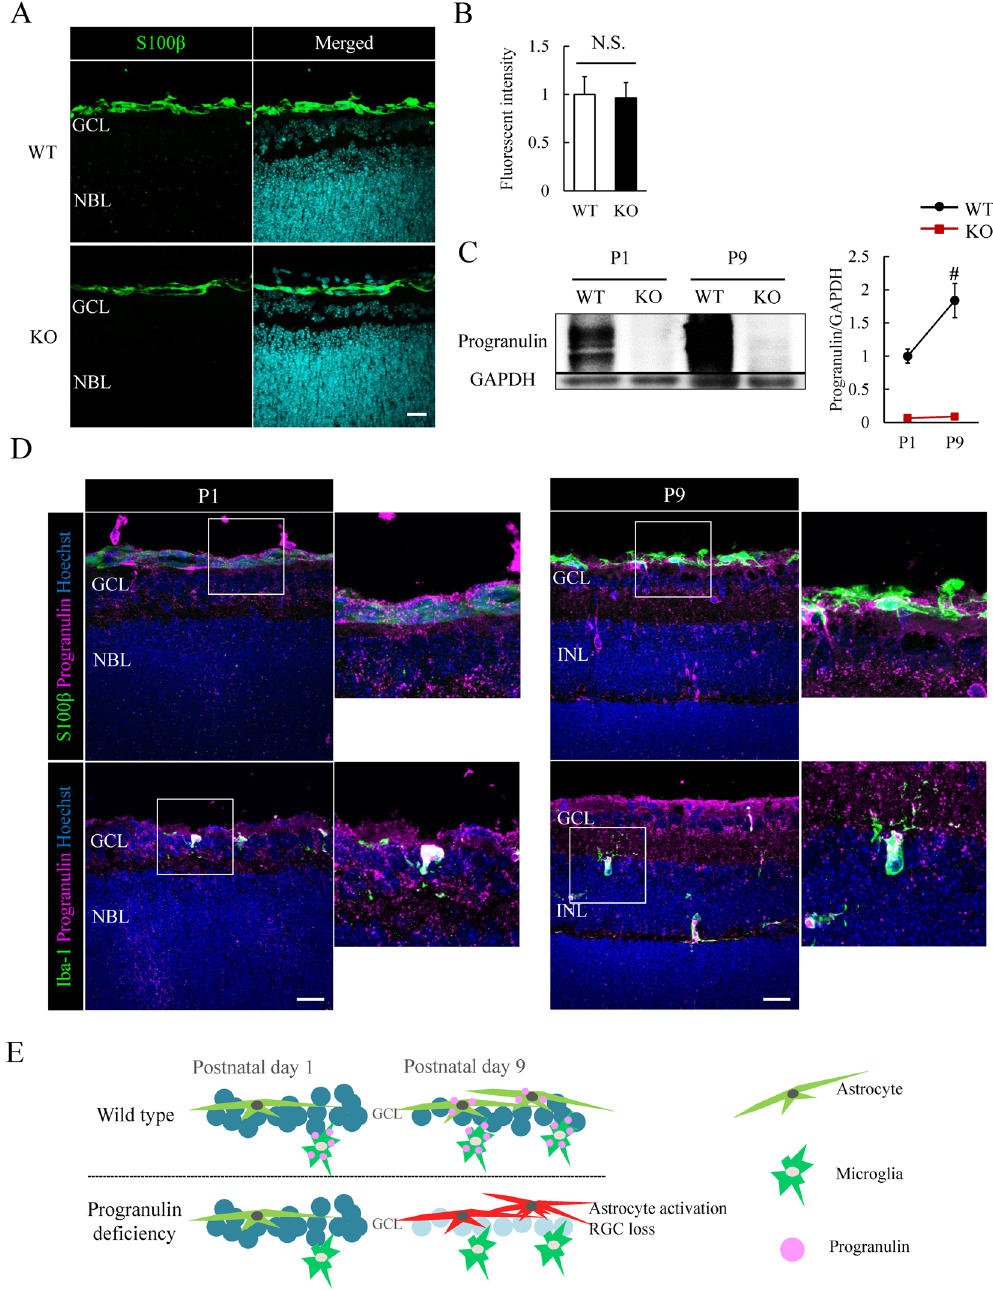
Figure 5. No change in retinal astrocytes in Grn − / − mice at P1. ( A , B ) Representative image show the S100 β + astrocytes (green) in P1 mice retina. There is no change in the expression of S100 β in Grn − / − mice at P1. Data are the means ± S.E.M. ( n = 4, 5). Student’s t -test. ( C ) Progranulin expression in P1 and P9 mice retina by western blotting. Progranulin expression is not observed in Grn − / − mice at P1 and P9 but is expression in WT mice at both times. The expression of progranulin is higher at P9 than at P1 in WT mice retina. Data are the means ± S.E.M. (WT: n = 3 or 4, KO: n = 2). # P < 0.05 vs. P1 WT (Student’s t -test). ( D ) Progranulin expression (magenta) in P1 and P9 WT mice retina by immunostaining. S100 β + astrocyte (green) is partly co-localized with progranulin in P9 WT retina but not in P1 WT retina. Iba-1 + microglia (green) are almost fully co-localized with progranulin in P1 and P9 retina. ( E ) Retinal development with or without progranulin. Progranulin is mainly secreted by microglia. Progranulin deficiency leads to astrocyte activation and RGC loss at P9, but not at P1. WT: Wild-type; KO: Knock-out; N.S.: Not significance. Scale bar = 20 μ m. The cropped blots are used in this Figure and the full-length blots are presented in Supplementary Fig.